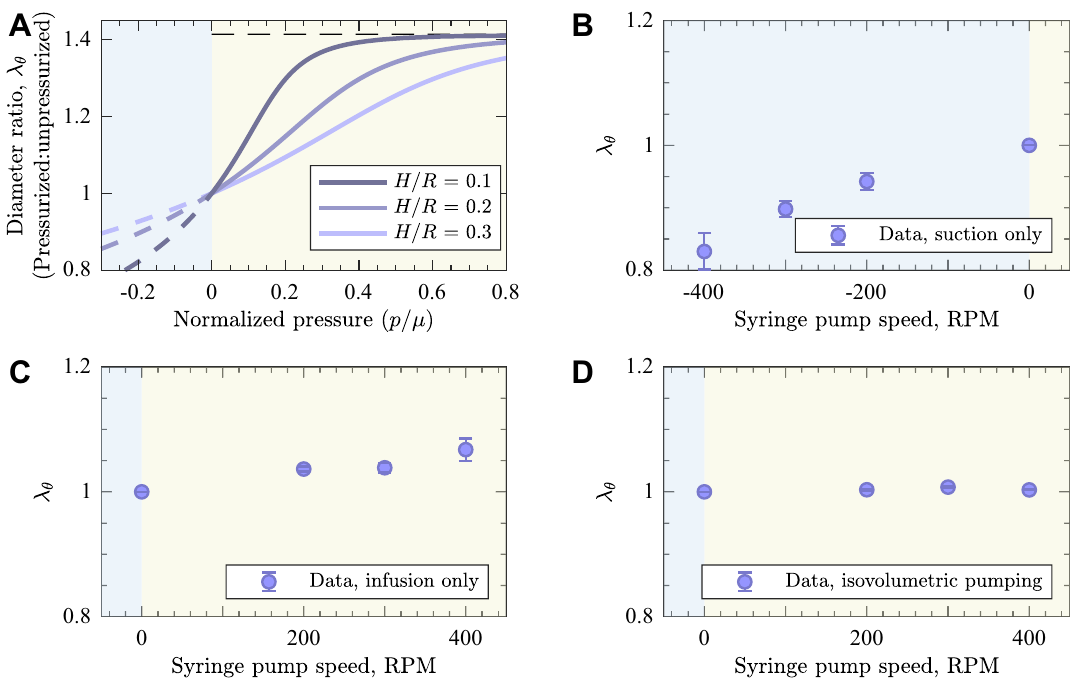
Figure 8. ( A ) A model of the response of a hyperelastic tube to suction and positive pressure loading. The dashed lines represent states that are not achievable due to buckling in compression or material lock-up in tension. ( B ) Change in vena cava diameter (proportional to stretch ratio (cid:31) θ ) during suction only using the MMSTC. ( C ) Change in vena cava diameter during infusion only using the MMSTC. ( D ) Change in vena cava diameter during isovolumetric infusion using the